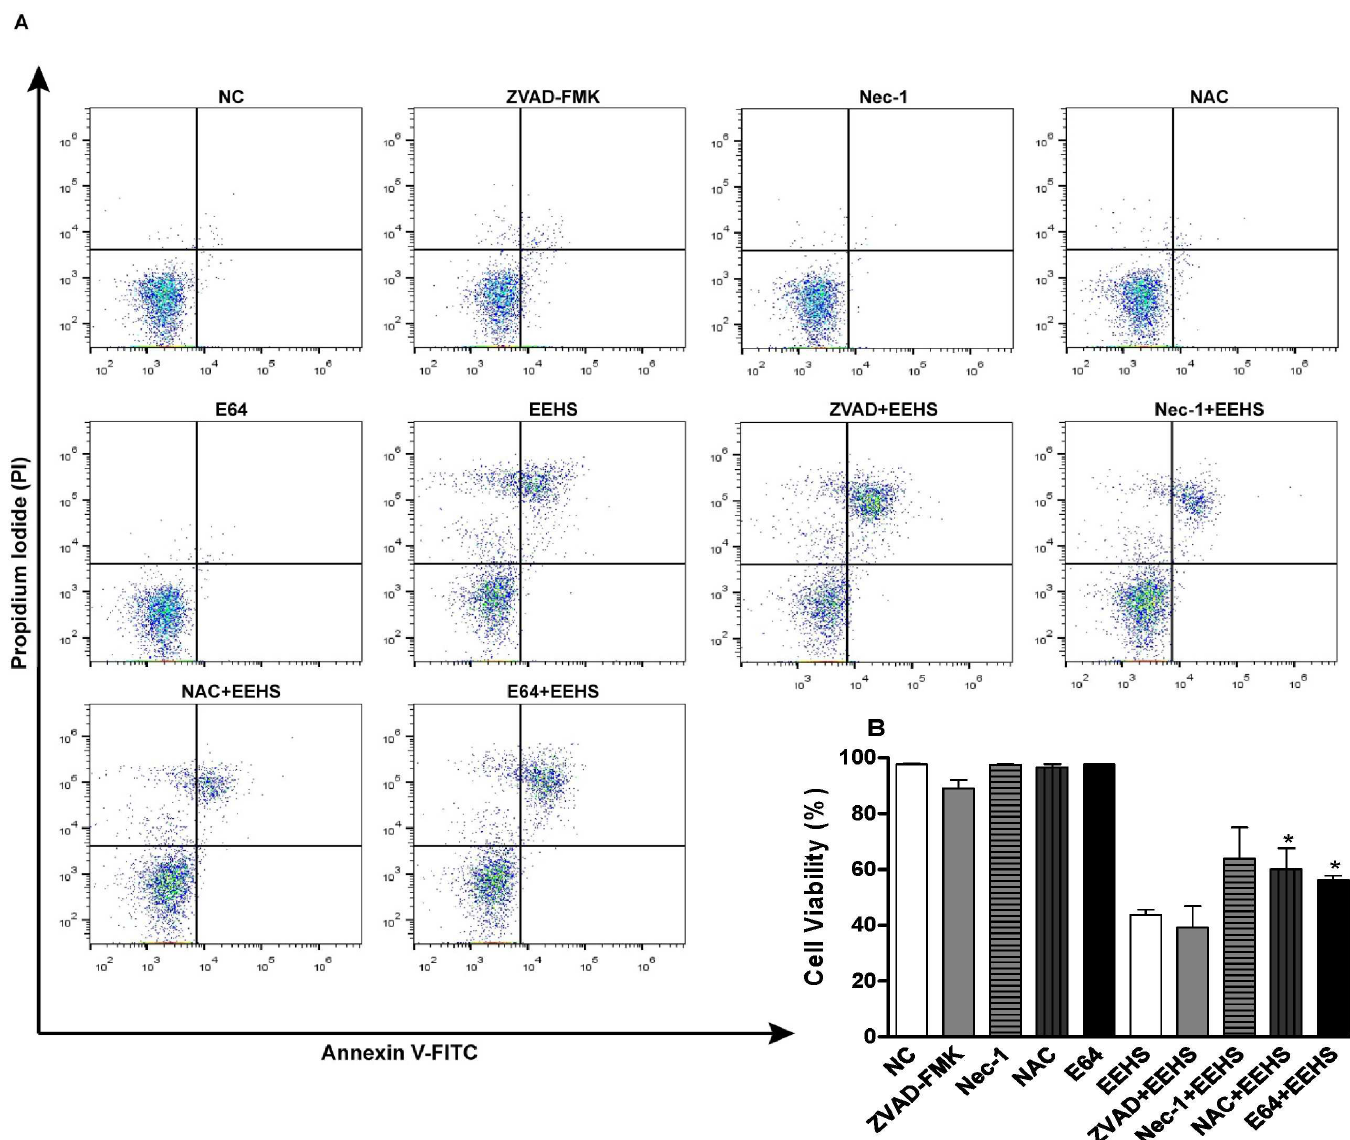
Fig 7. Cytotoxic activity of the EEHS in the acute myeloid leukemia cell line Kasumi-1 in the presenceof cell death inhibitors. (A) Dot plots of the flow cytometry data of cells stainedwith propidiumiodideand annexin-V-FITC in the presence of inhibitors Z-VAD-FMK, Nec-1, NAC, or E64 and in the presenceof the EEHS combinedwith each of these inhibitors. (B) Percentage of cell viabilityobtainedfrom dot plots at the EEHS concentration of 160 μ g/mL. * P < 0.05 when the treated groups were comparedwith the control